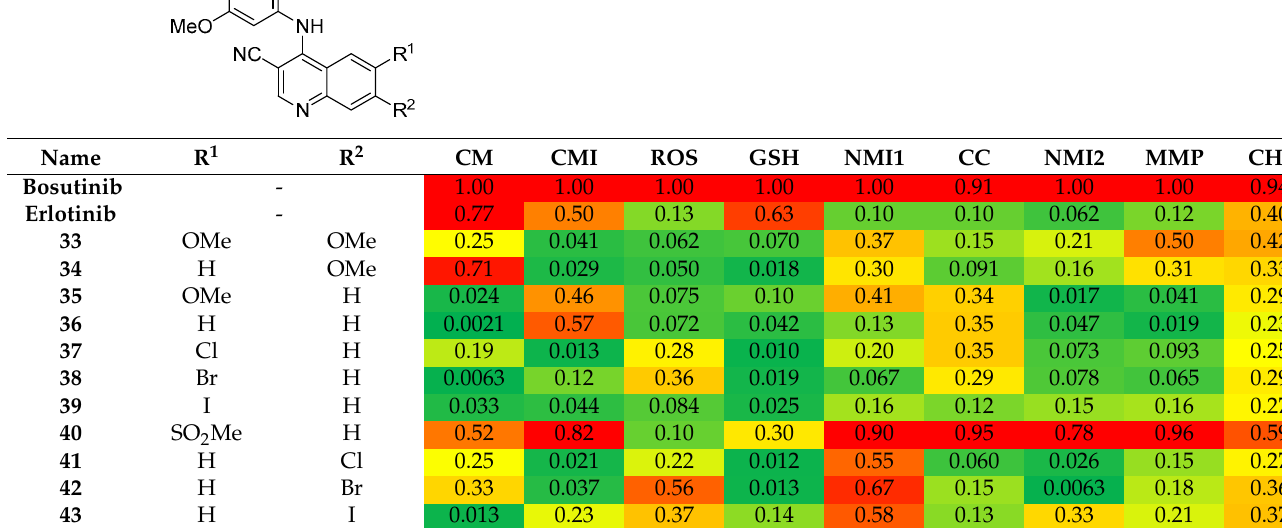
a Abbreviations from columns left to right. CM: Cell morphology; CMI: Cell membrane integrity; ROS: Reactive oxygen species; GSH: Glutathione; NMI1: Nuclear membrane integrity 1; CC: Cell Cycle; NMI2: Nuclear membrane integrity 2; MMP: Mitochondrial membrane potential; CHI: Cell Health Index. b Traffic light colouring matching classifier values (Red–Green: high toxicity risk–low toxicity risk). c all n =